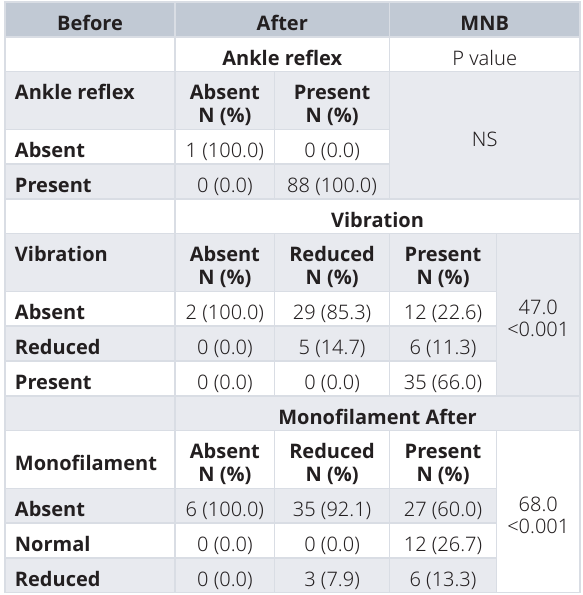
Table 4. Peripheral neuropathy indicators (ankle reflex, tuning fork vibration and 10 g monofilament) in group A (Prediabetics with PN) before and after vitamin D